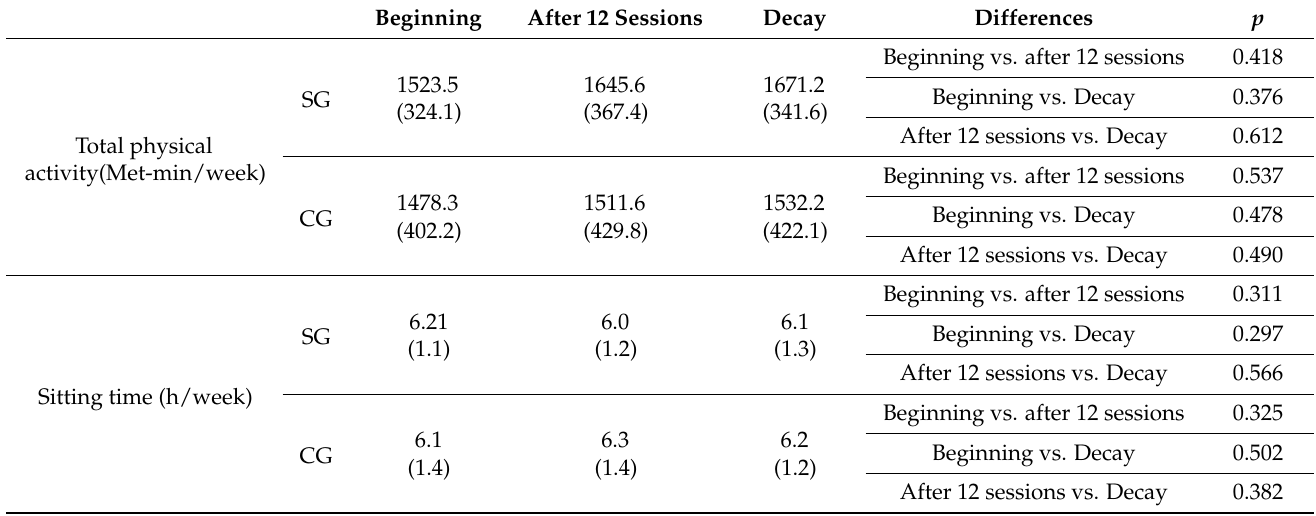
Table 2. Physical activity and sitting time of each group at the beginning, after 12 sessions of sauna and after two weeks of decay.